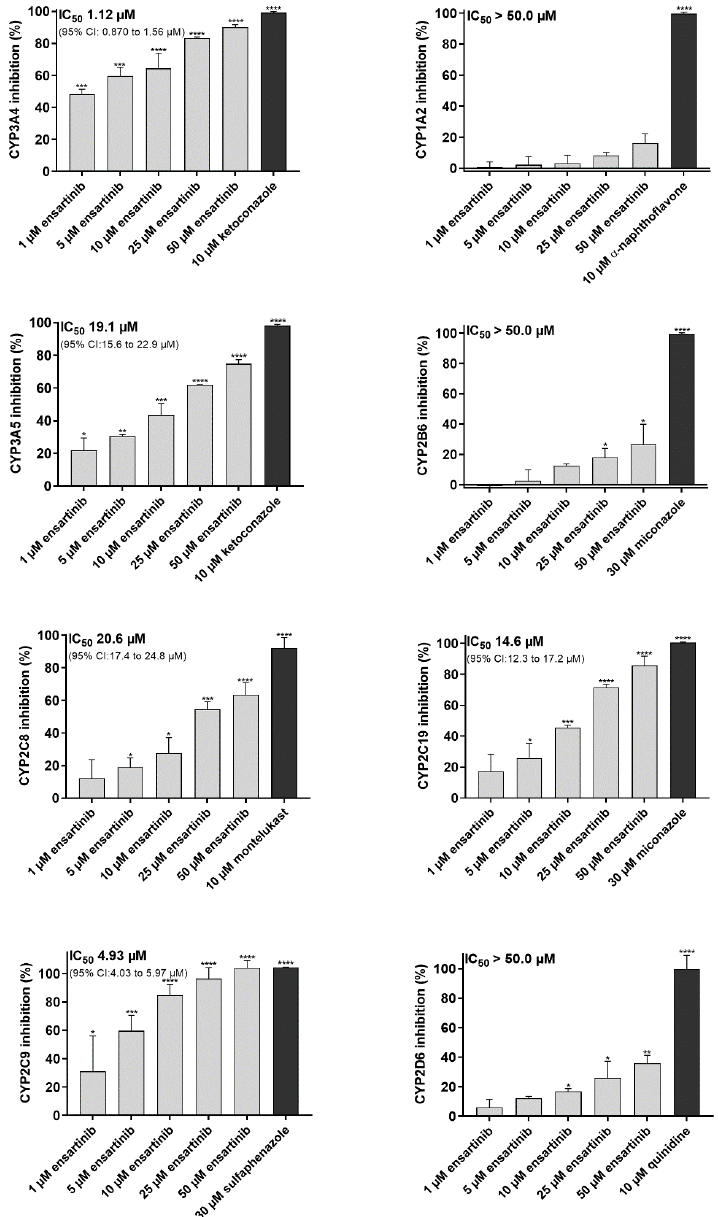
Figure 3. Effect of ensartinib on the activities of human cytochrome P450 (CYP)1A2, CYP3A4, CYP3A5, CYP2B6, CYP2C19, CYP2C8, CYP2C9, and CYP2D6 isoforms assessed using the commercial